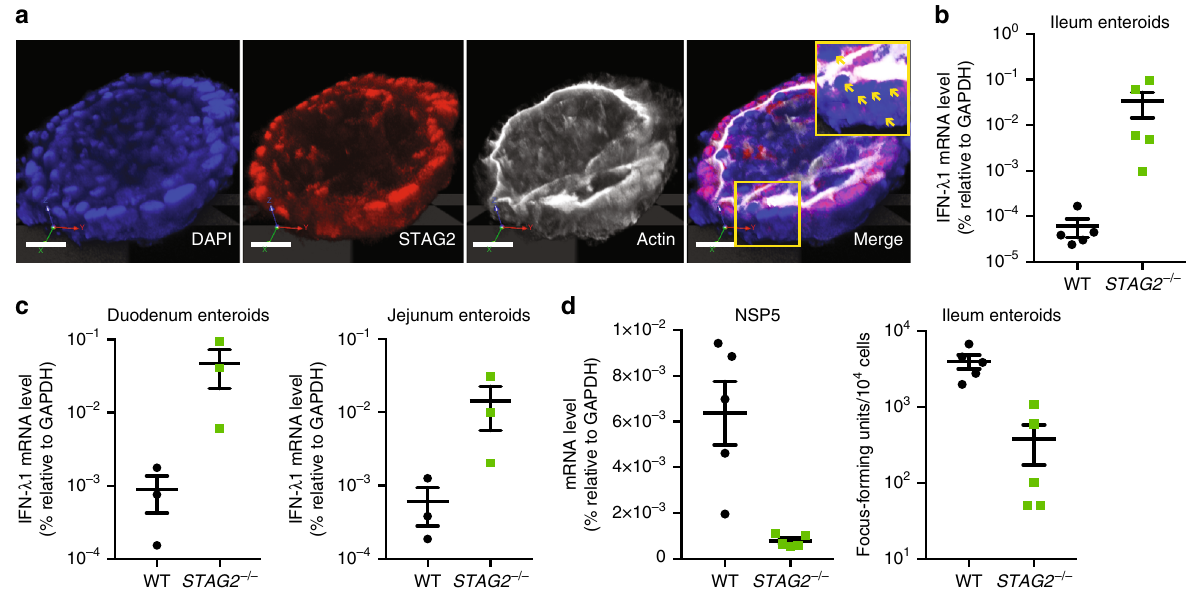
Fig. 4 STAG2 depletion induces IFN expression in human intestinal enteroids. a 3D immuno fl uorescence analysis of a single ileal enteroid transduced with a lentiviral vector expressing Cas9 and STAG2 sgRNA: nucleus (DAPI, blue), STAG2 (red), and actin (phalloidin, white). Scale bar: 50 μ m. Yellow box marks the region enlarged in the inset. Yellow arrows in the inset panel indicate IECs that are completely STAG2 knocked out. b , c Steady-state IFN- λ 1 expression was measured by RT-qPCR in WT and partial STAG2 − / − ileum enteroids ( n = 4) ( b ) and in duodenum and jejunum enteroids ( n = 3) ( c ). d WT and partial STAG2 − / − enteroids were infected with RV (MOI = 5) and viral NSP5 level and virus yields were determined at 24 h.p.i. All scatter plots in b – d are calculated based on comparison between WT and STAG2 mosaic (~30% KO) enteroids. For all fi gures, experiments were repeated at least three times in triplicates. Data are represented as mean ±